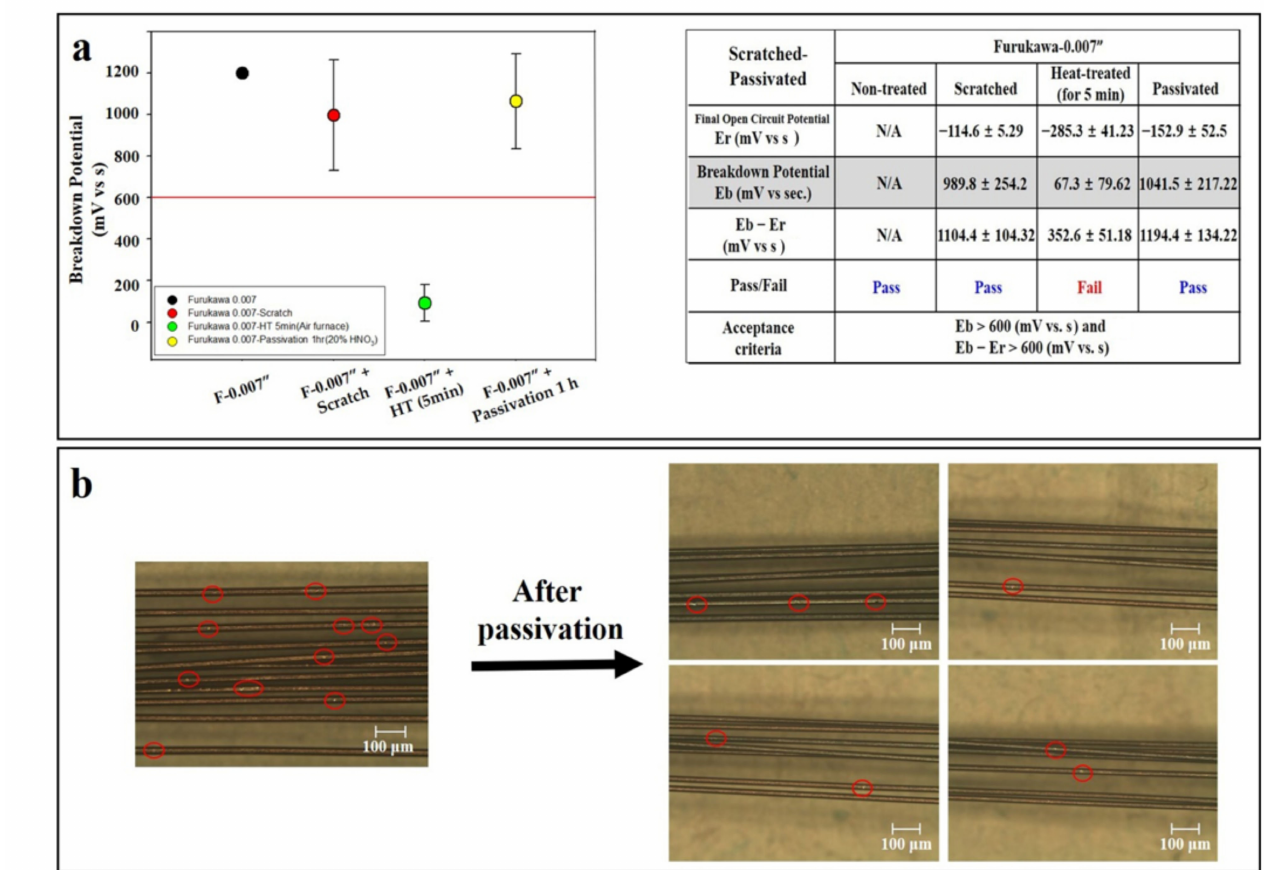
Figure 6. Corrosion test result after passivation treatment of scratched NiTi wire. ( a ) Potential change in wire by scratch, heat treatment in air furnace, passivation, and ( b ) optical microscopic images of wire surface morphology are represented. Red lines indicate acceptance criteria in this study as mentioned in Materials and Methods section. Red circles indicate areas of corrosion by friction. ‘F’ and ‘P’ are acronyms for ‘Furukawa’ and ‘passivation’,